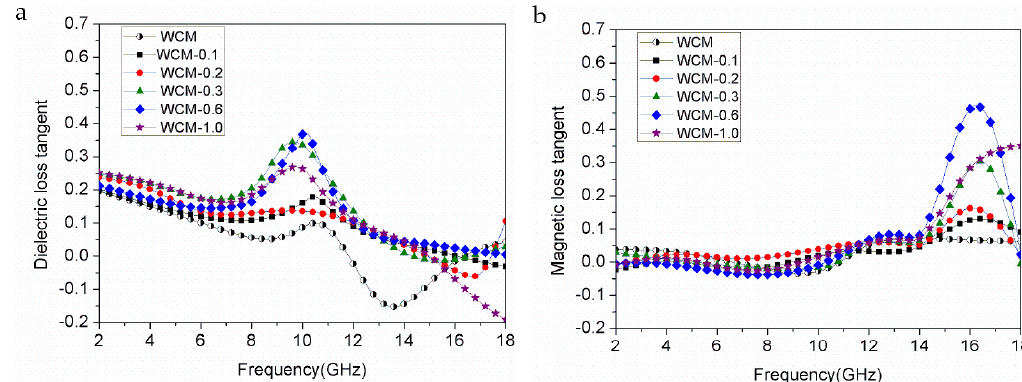
Figure 6. Dielectric loss tangent and magnetic loss tangent of α-Fe/Fe 3 C/woodceramic nanocomposites as a function of frequency ( a ) dielectric loss tangent; ( b ) magnetic loss tangent.